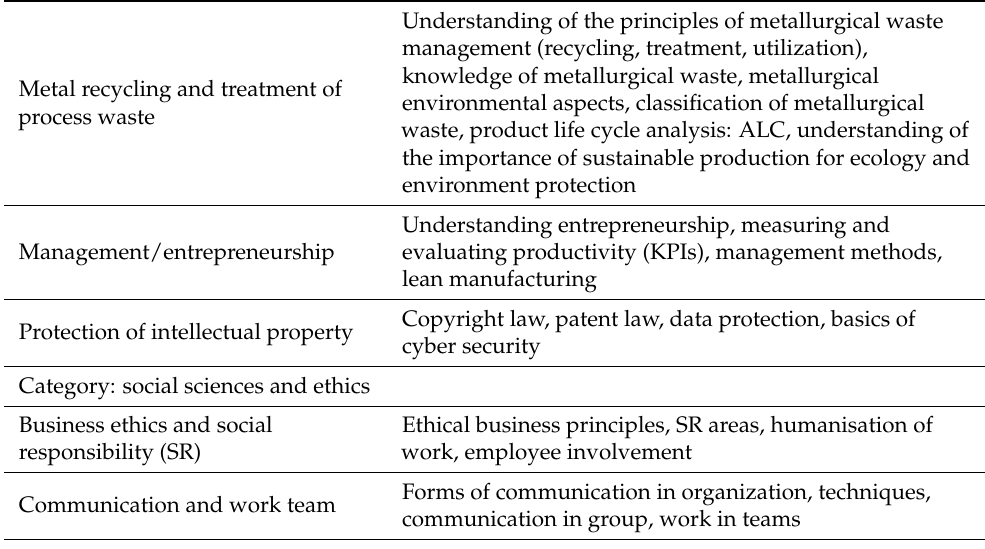
Metal recycling and treatment